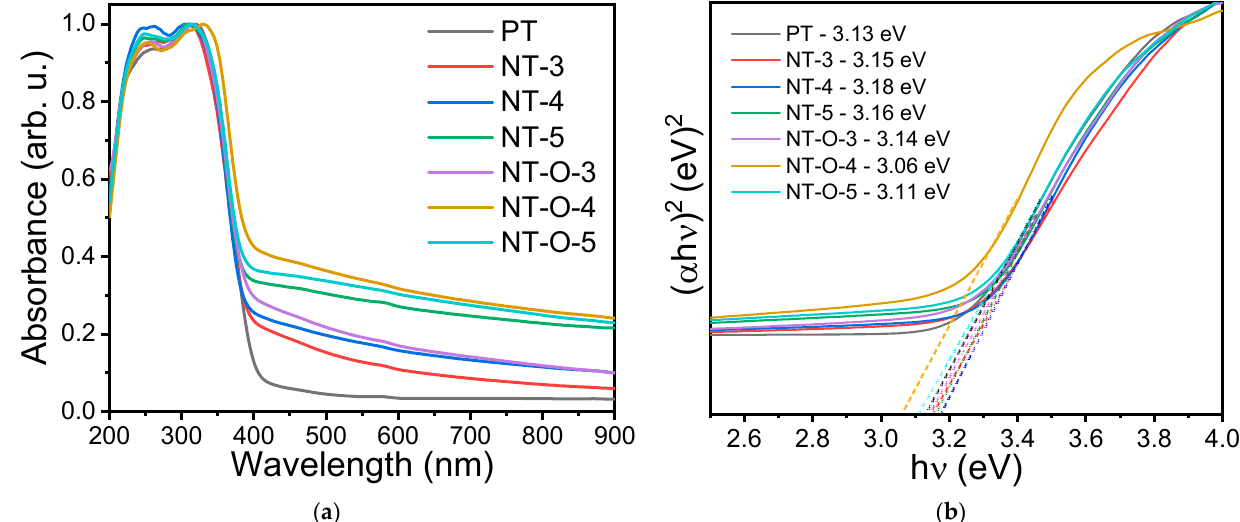
Figure 3. ( a ) UV ‐ Vis DR spectra and ( b ) Tauc plots for investigated samples. Figure 3. ( a ) UV-Vis DR spectra and ( b ) Tauc plots for investigated